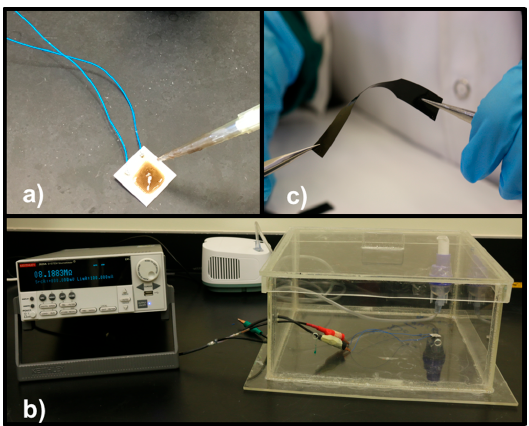
Figure 2. Samples coating on the interdigitated electrode ( a ); and the setup for the pressure sensing experiment under controlled conditions ( b ). A picture showing the flexibility of the polyvinylidene Table 1. Composition of the composite samples.